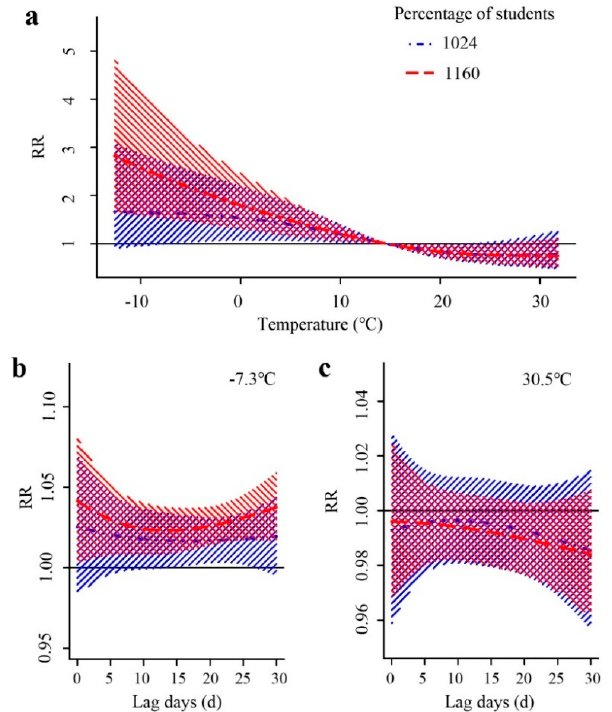
Figure 5. The effect of temperature on mumps when the proportion of primary and secondary school students is high ( P 75 (1160/10,000), red) and when the proportion of primary and secondary school students is low ( P 25 (1024/10,000), blue). ( a ) represents the effect of daily average temperature on mumps. ( b , c ) represent the effects of temperature on mumps at different lag times.